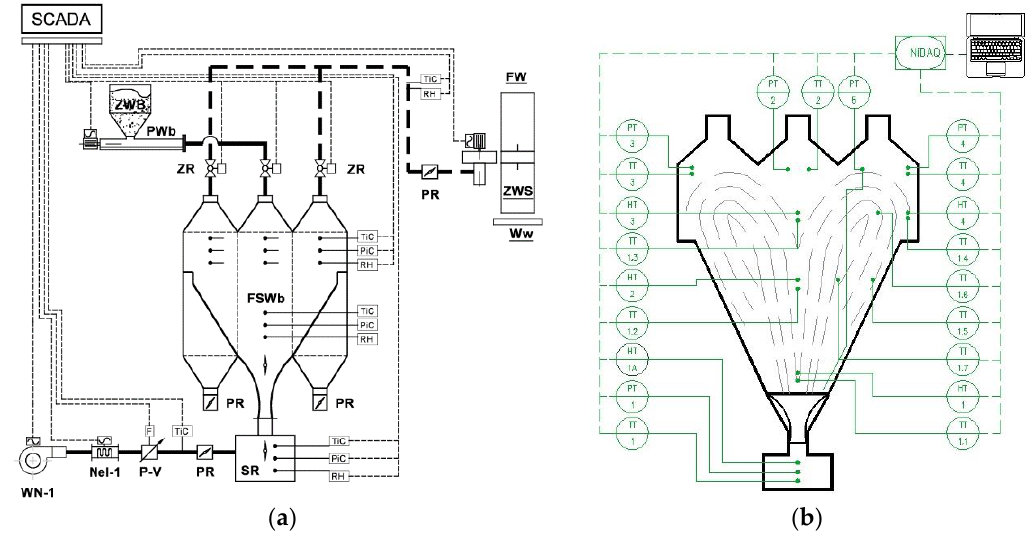
Figure 4. Schematic diagram of the technological system ( a ) and measurand in the apparatus ( b ).